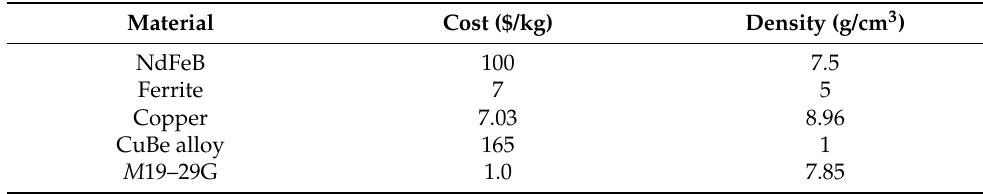
Table 12. Material cost and